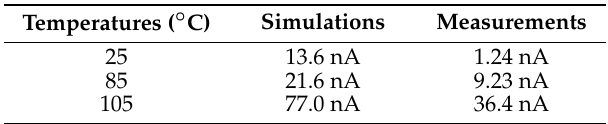
Table 1. Simulated and measured dark currents versus temperature for the proposed CA with enhanced dark current cancellation.